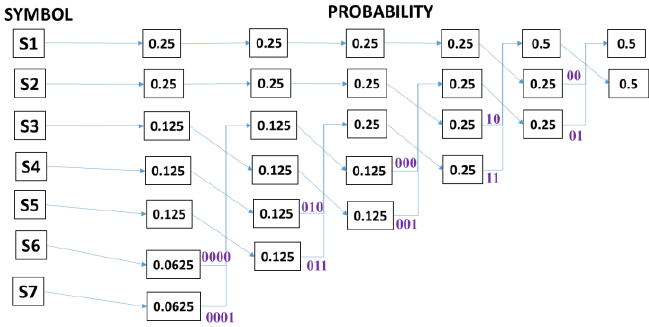
Figure 3. Huffman encoding: average word length =